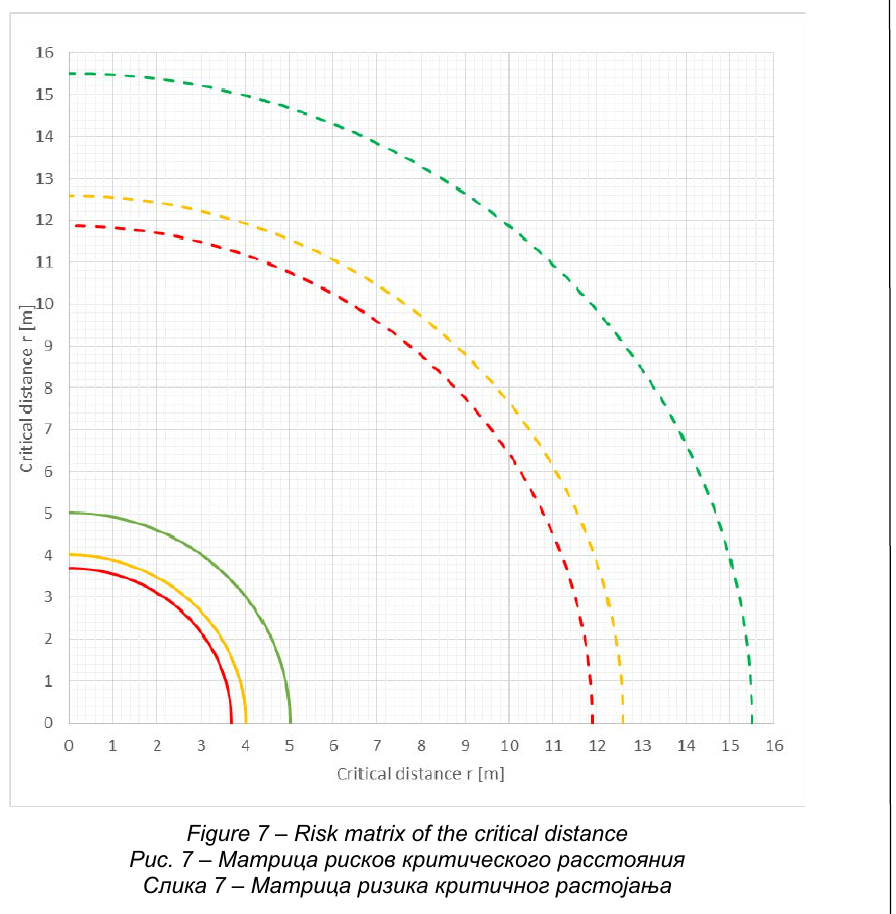
Figure 7 – Risk matrix of the critical distance Рис . 7 – Матрица рисков критического расстояния Слика 7 – Матрица ризика критичног